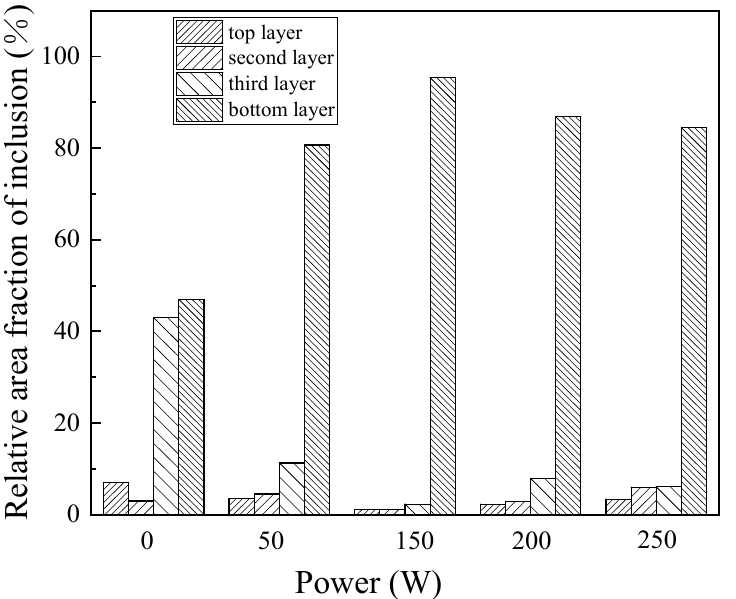
Figure 7. Variation of relative area fraction of inclusion with ultrasonic power.